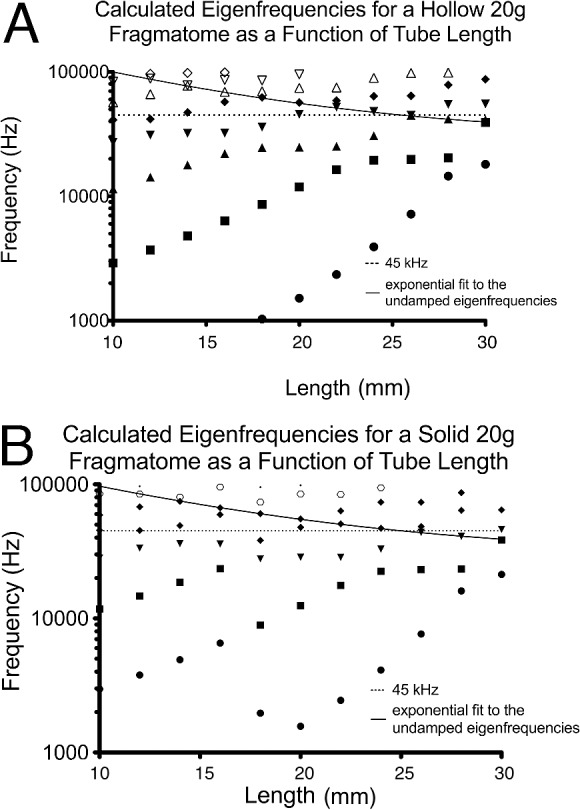
Calculated eigenfrequencies as a function tube length for (A) a hollow 20-gauge tube with a standard needle wall thickness in nine different families of eigenmodes and for (B) a solid 20-gauge tube in eight families of eigenmodes. The exponential one phase decay fit for the undamped eigenfrequencies of all gauges studied (20-, 23-, 25-, and 27-gauge) is drawn as a solid line. It is notable that the undamped eigenfrequencies at different fragmatome lengths belong to different families of eigenmodes. The normal excitation frequency used in most clinical instruments (45 kHz) is noted with a dashed line. These two lines are for reference and comparison.